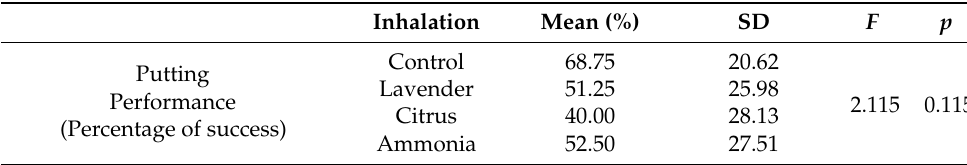
Table 2. Putting performance according to olfactory inhalation ( n =